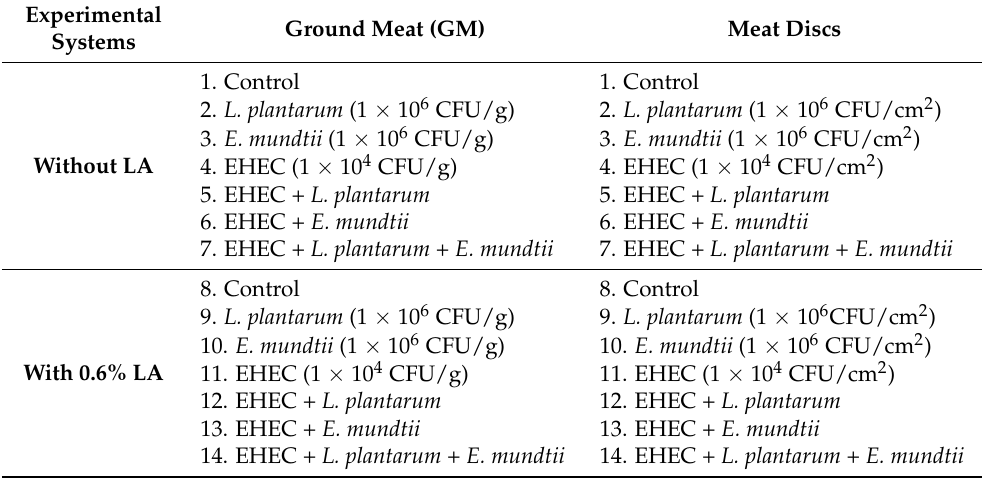
Table 1. Batches used for the analysis of the antagonistic capacity of LAB with and without 0.6% lactic acid